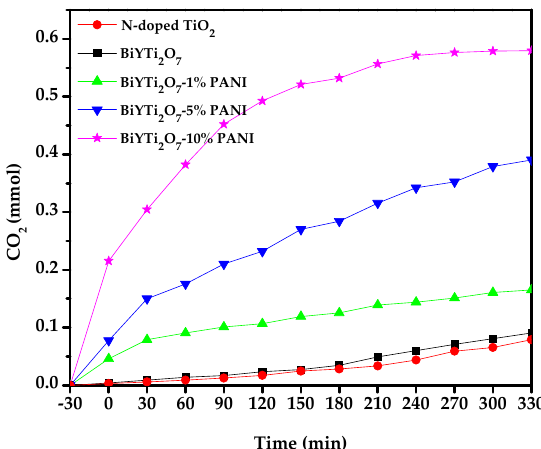
Figure 15. CO 2 production kinetics during the photocatalytic degradation of AG with different PANI-modified BiYTi 2 O 7 and N-doped TiO 2 as a catalyst under visible light irradiation.